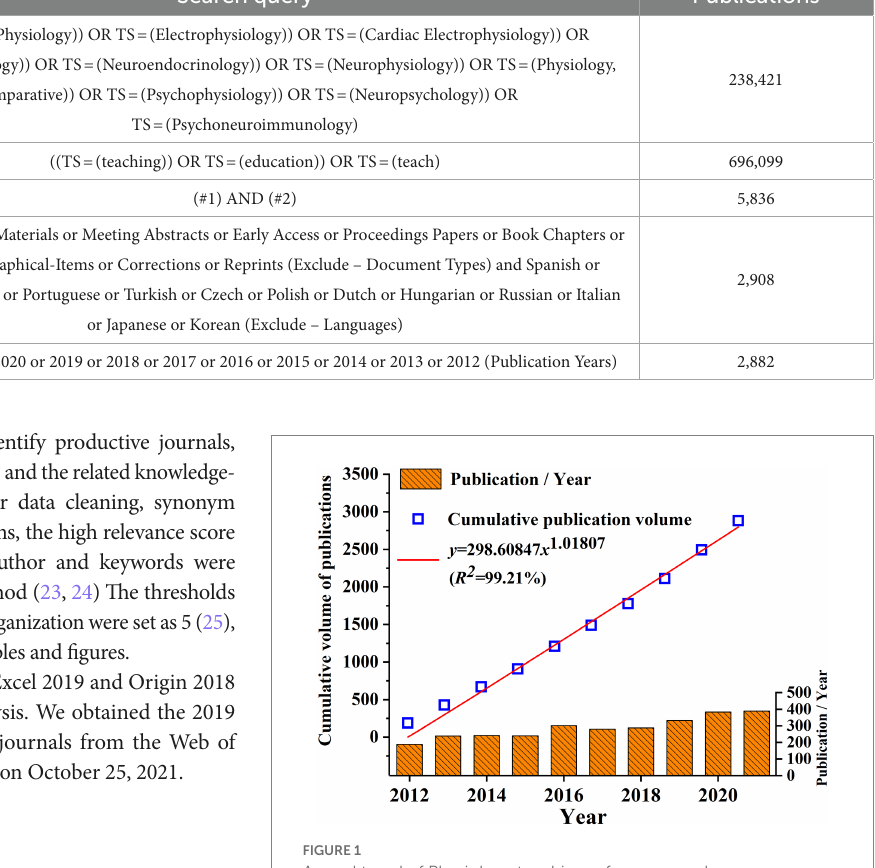
TABLE 1 Search strategy of physiology teaching reforms.